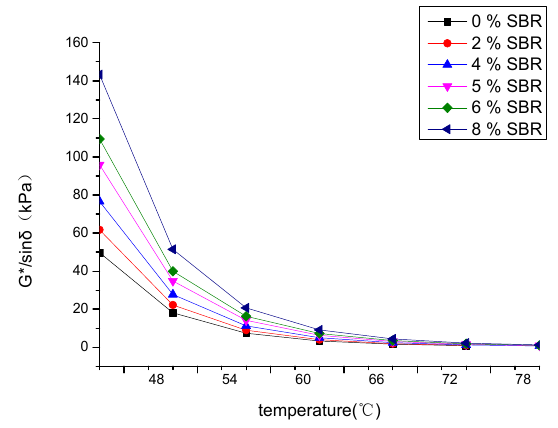
Figure 11. Rutting factor G*/sin δ with different temperatures.